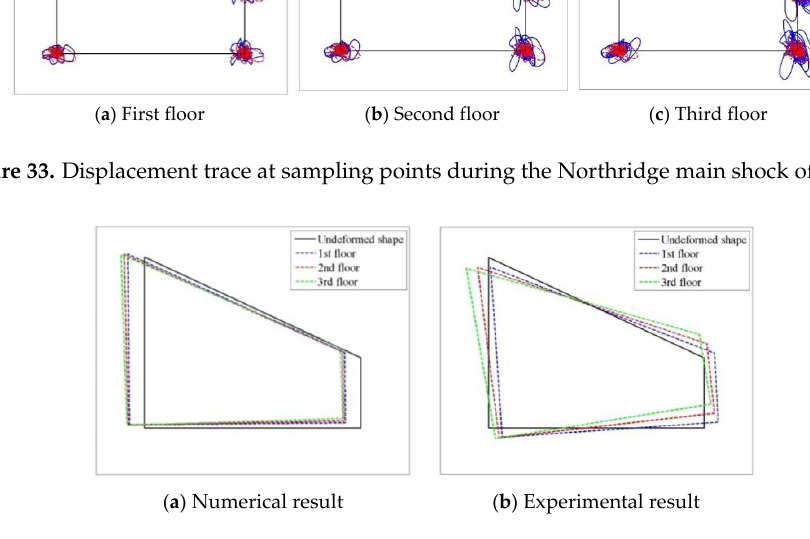
Figure 34. Distortion of each floor due to the Northridge main shock (Run 19) at 8.6 s.